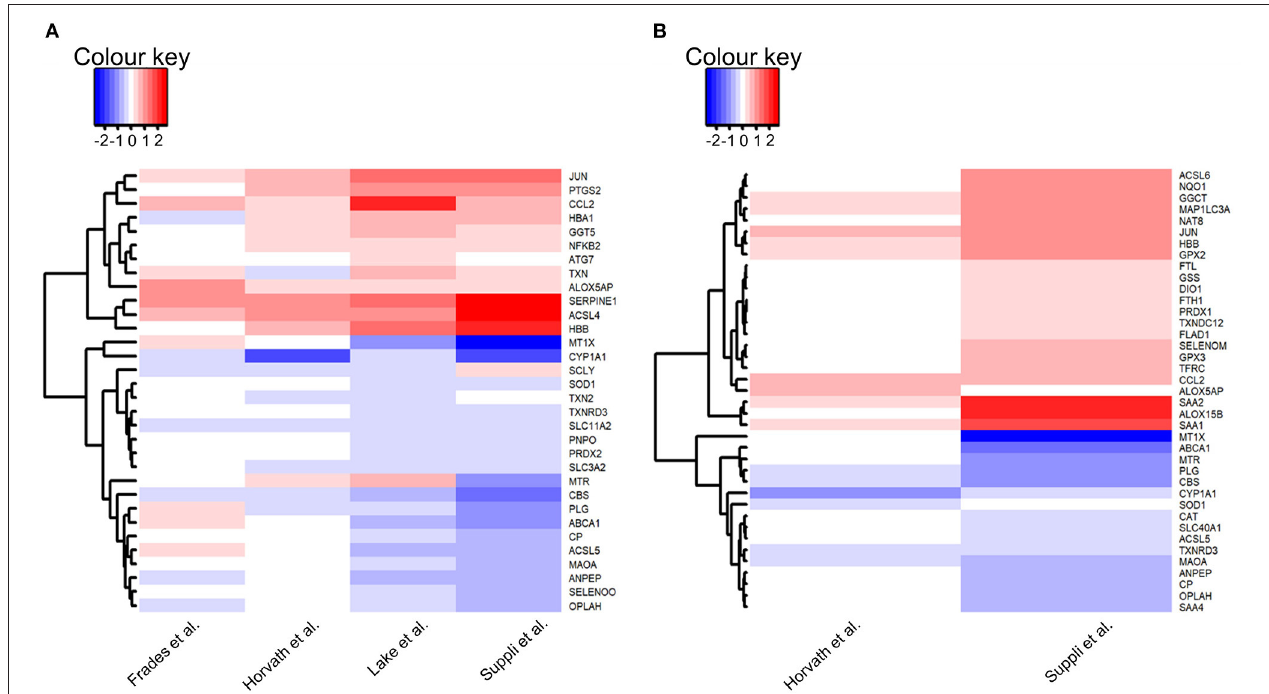
FIGURE 4 | Heatmaps of genes of interest in liver samples: (A) Normal-weight healthy controls vs. NASH; (B) Healthy obese controls vs. NASH. Genes of interest were defined as genes for which the log fold change was in the same direction in the majority of datasets (HC: 3/4 datasets, HOC: 2/2 datasets) and with an adjusted P -value < 0.05 in at least 50% of these datasets. Red depicts increased expression in NASH compared to controls and blue depicts decreased expression in NASH compared to controls. Heatmaps were generated using the heatmap.2 function in gplots (version 3.0.3) in R (version